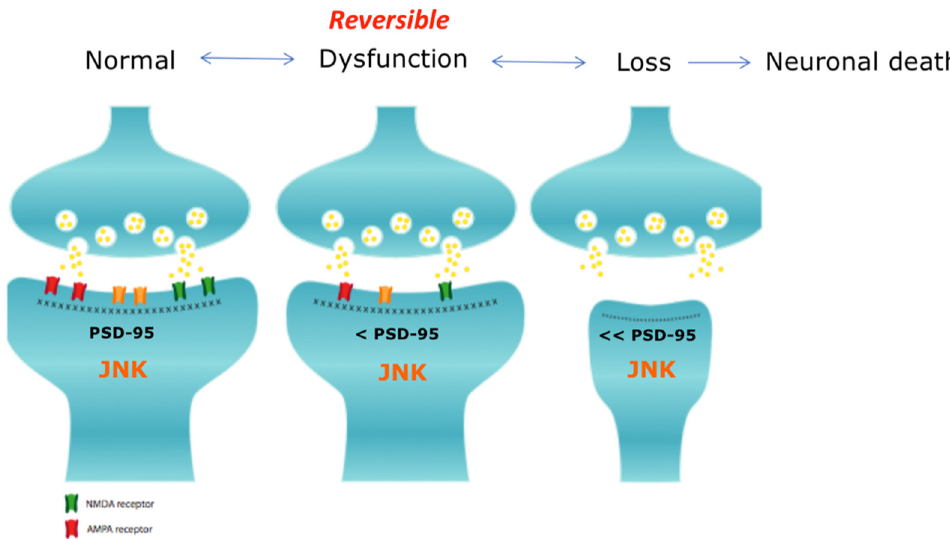
Figure 4. Synaptic pathology. The presynaptic and the post-synaptic elements are here